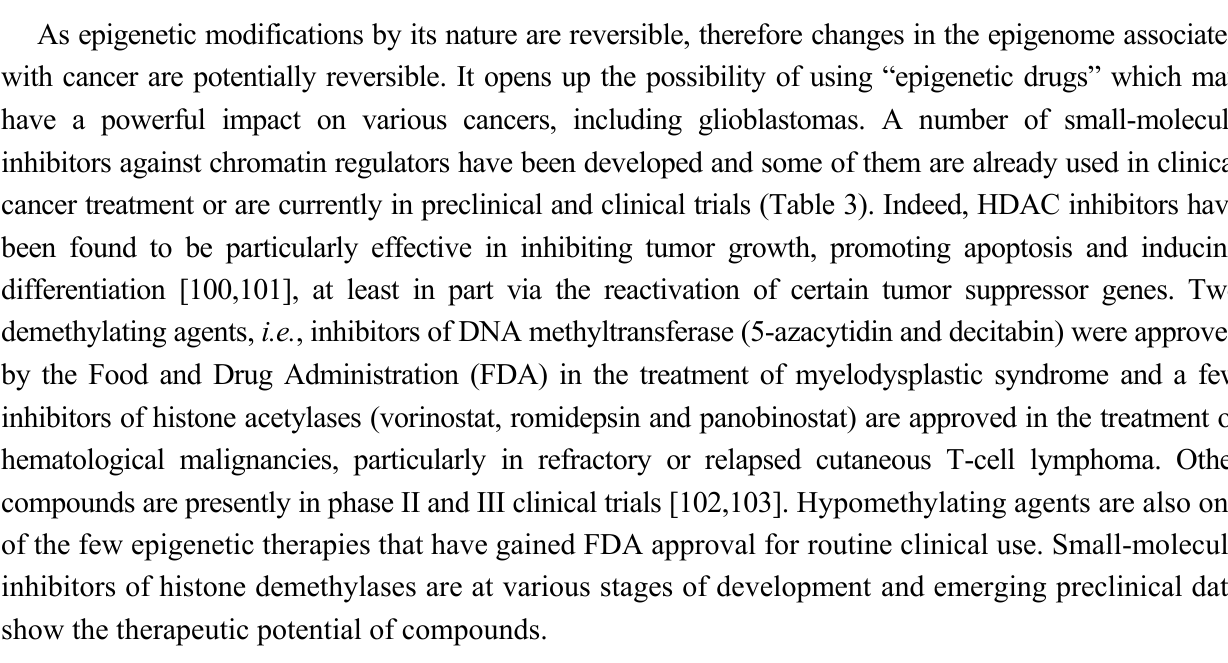
Table 3. Small-molecule inhibitors in preclinical and clinical trials for glioblastoma treatment.